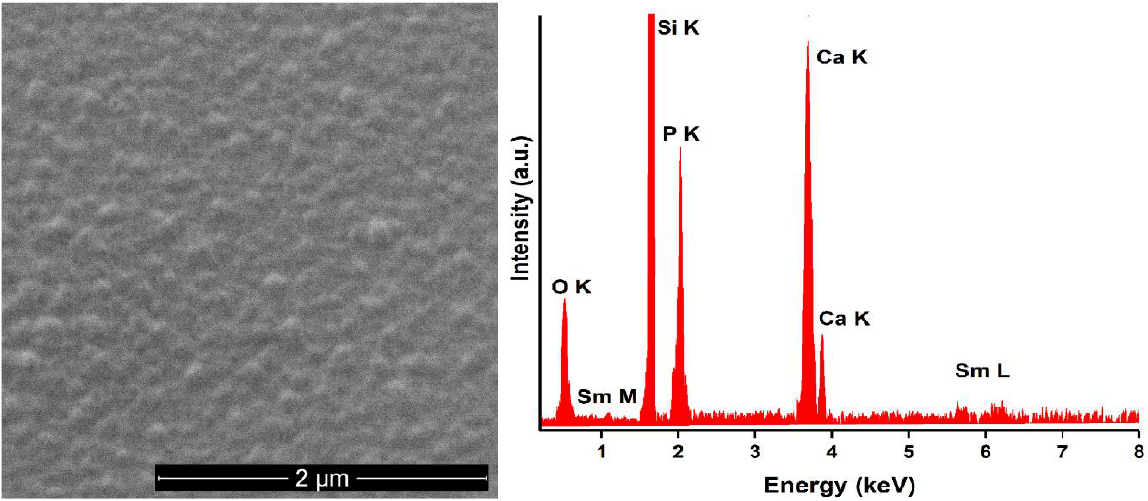
Figure 3. SEM micrograph ( left ) and EDX spectra ( right ) obtained on 5SmHAp deposited in Si substrate.